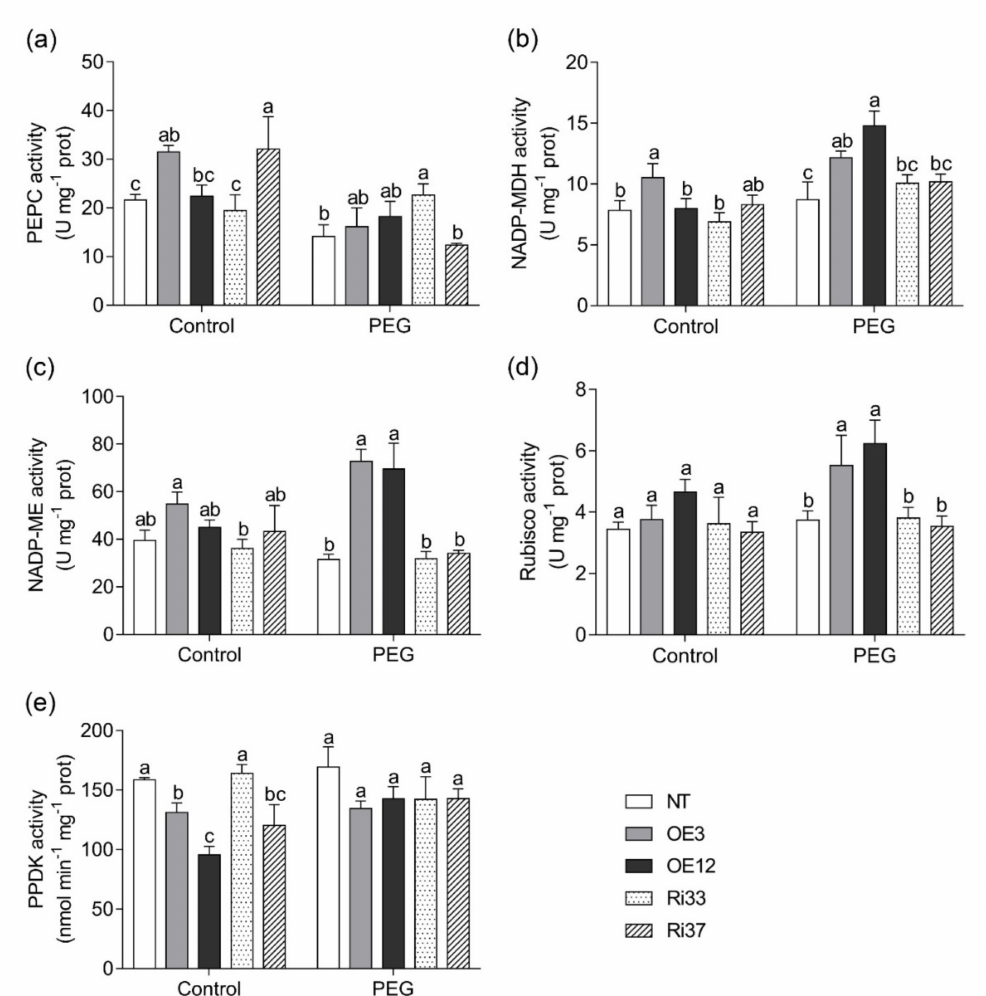
Figure 5. Effects of CgbHLH001 overexpression on the activity of photosynthetic enzymes of maize seedlings under drought stress. ( a ) PEPC activity; ( b ) NADP-MDH activity; ( c ) NADP-ME activity; ( d ) Rubisco activity; ( e ) PPDK activity. NT, non-transgenic plant; OE3 and OE12, CgbHLH001 - overexpressed T 3 maize lines; Ri33 and Ri37, ZmbHLH -RNAi T 3 maize lines. PEG, 15% PEG 6000. PEPC, phosphoenol-pyruvate carboxylase; NADP-MDH, NADP-malic dehydrogenase; NADP-ME, NADP-malic enzyme; Rubisco, ribulose-1, 5-bisphosphate carboxylase/oxygenase; PPDK, pyru- vate orthophosphate dikinase. Different lowercase letters above the columns indicate significant differences between NT plants and transgenic lines under the same condition (Tukey’s test, p < 0.05). Values are means ± SD of three